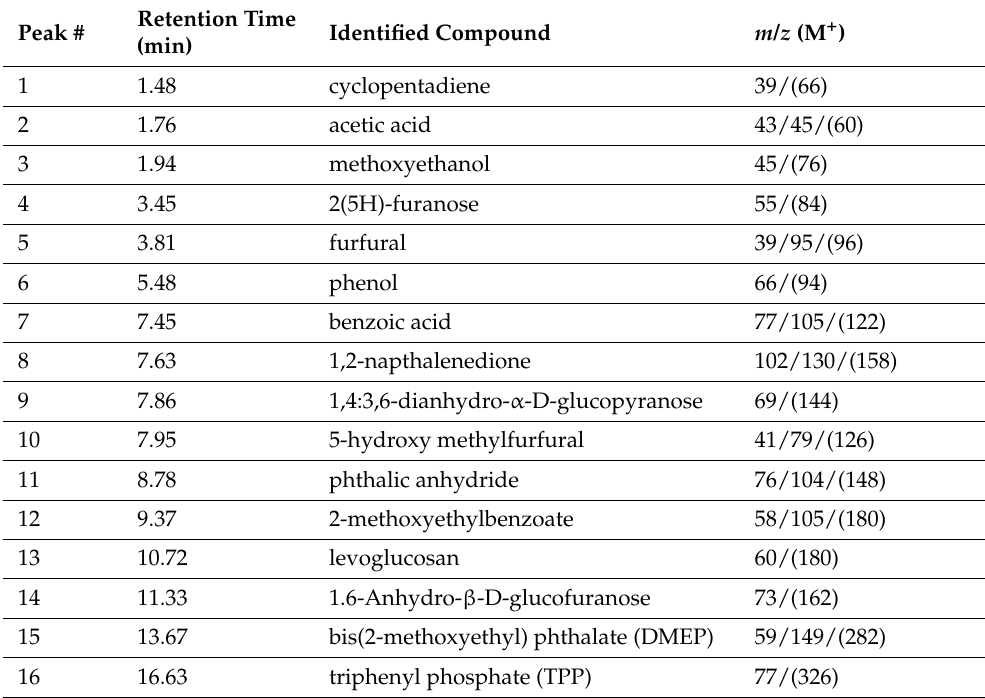
Figure 4. Pyrogram of cel A5a, identified as Cellulose Acetate (CA). Indicated identified compounds are listed in Table 2. Table 2. Indicative pyrolysis products identified in cel A5a. Presented are the peak label, the retention time in minutes, the identity of the compound and the characteristic mass ions (AMU) and the molecular ion between brackets.